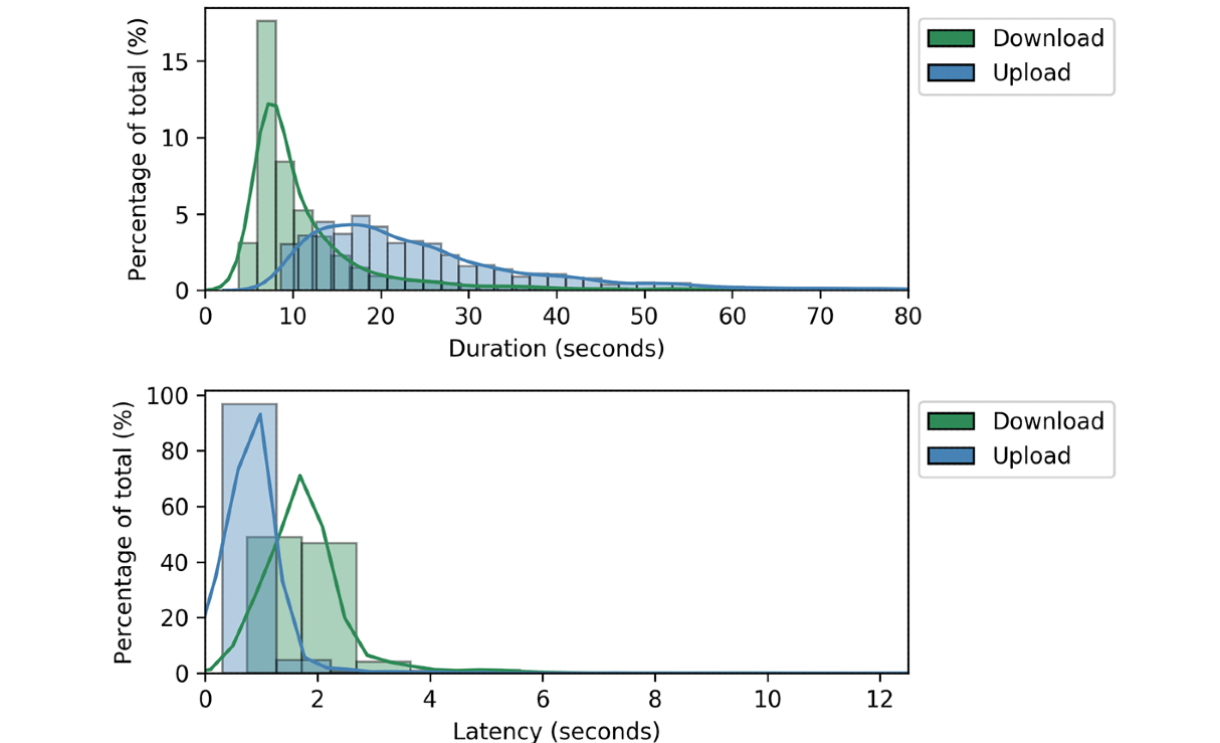
Figure 5. Distributions of upload and download duration (top) and latency (bottom) recorded for Carrier A over the course of Beacon testing.